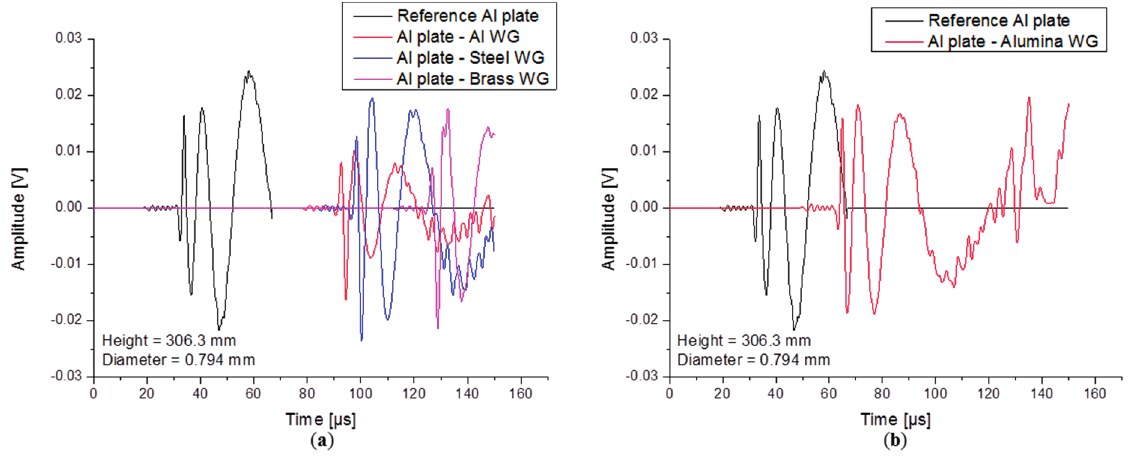
Figure 14. Calculated signals for ( a ) metallic waveguides and ( b ) ceramic